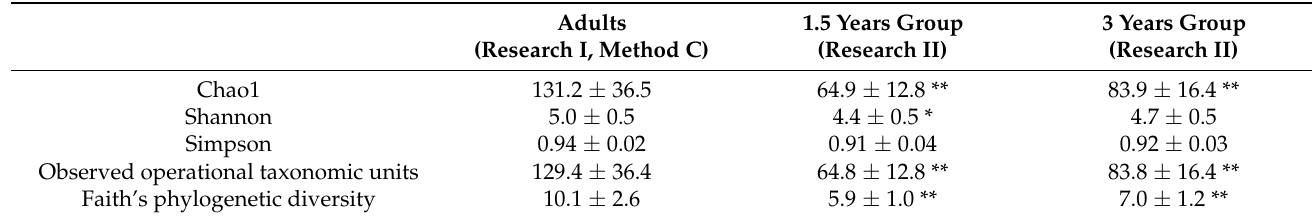
Table 4. Diversity indices of the adult and toddler gut microbiota.